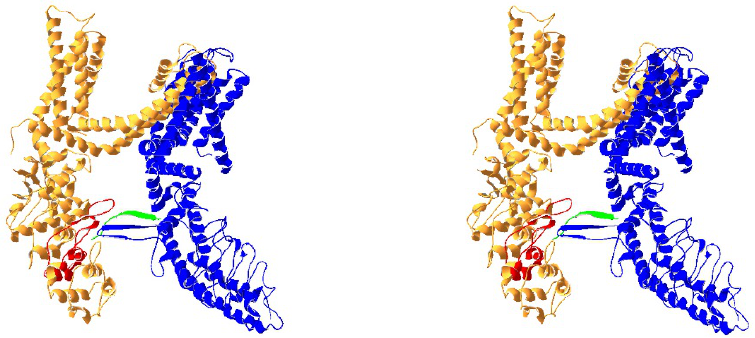
Figure 1. Ribbon diagram of TRPV1 structure (PDB, 3J5P) showing proximity of the first ARD (red) in the N-terminus of TRPV1 to the distal C-terminus (green) from an adjacent TRPV1 subunit (stereo view in parallel).